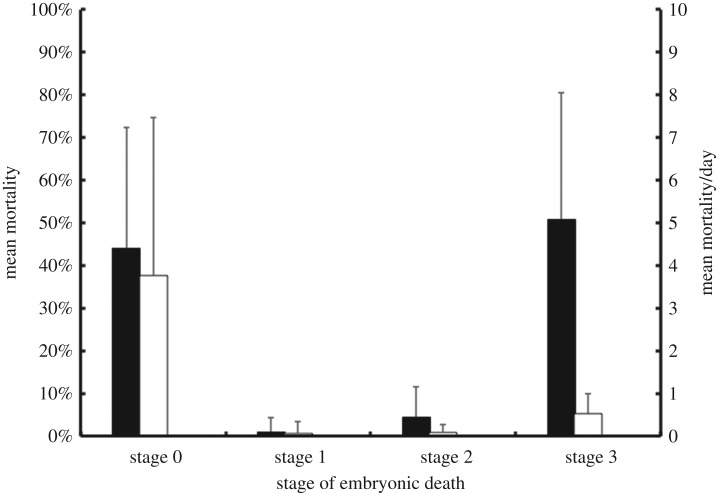
The primary axis (black bars) represents the overall mean embryo mortality (± standard deviation) per developmental stage. The secondary axis (white bars) represents the mean number of embryos dying per day during each developmental stage.